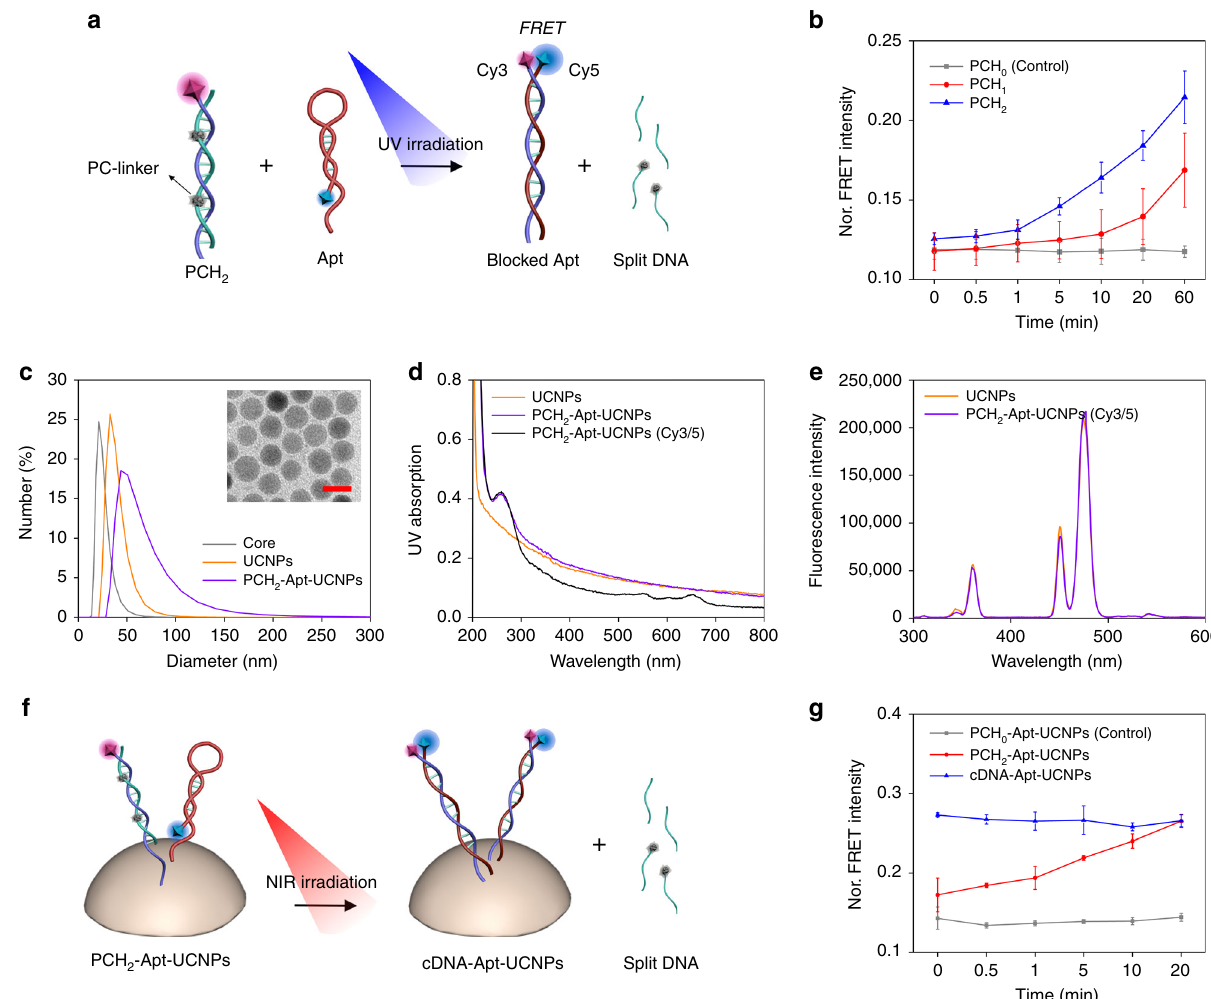
Fig. 2 Design and characterization of the aptamer-based light-responsive nanoplatform. a Schematic illustration of the strand replacement reaction between Cy5-labeled Apt and Cy3-labeled PCH 2 under UV light irradiation. b Kinetic analysis of the Fo ̈ rster resonance energy transfer (FRET) signal between Cy3 and Cy5 in the case of PCH 0 , PCH 1 , and PCH 2 . Error bars represent the standard deviation of three independent experiments. Data are presented as mean values ± S.D. c Dynamic light scattering spectra of the UCNP core, UCNPs and PCH 2 -Apt-UCNPs. Inset: TEM image of the UCNP core. The red scale bar represents 20 nm. d UV absorption of UCNPs, PCH 2 -Apt-UCNPs and PCH 2 -Apt-UCNPs (Cy3/5) (PCH 2 -Apt-UCNPs containing the Cy5-labeled Apt and Cy3-labeled PCH 2 ). e Luminescence spectra of UCNPs and PCH 2 -Apt-UCNPs (Cy3/5) under 980 nm excitation. f Schematic illustration of the NIR-responsive hybridization switch of PCH 2 -Apt-UCNPs. g Kinetic analysis of the FRET signal of PCH 2 -Apt-UCNPs. Error bars represent the standard deviation of three independent experiments. Data are presented as mean values ±